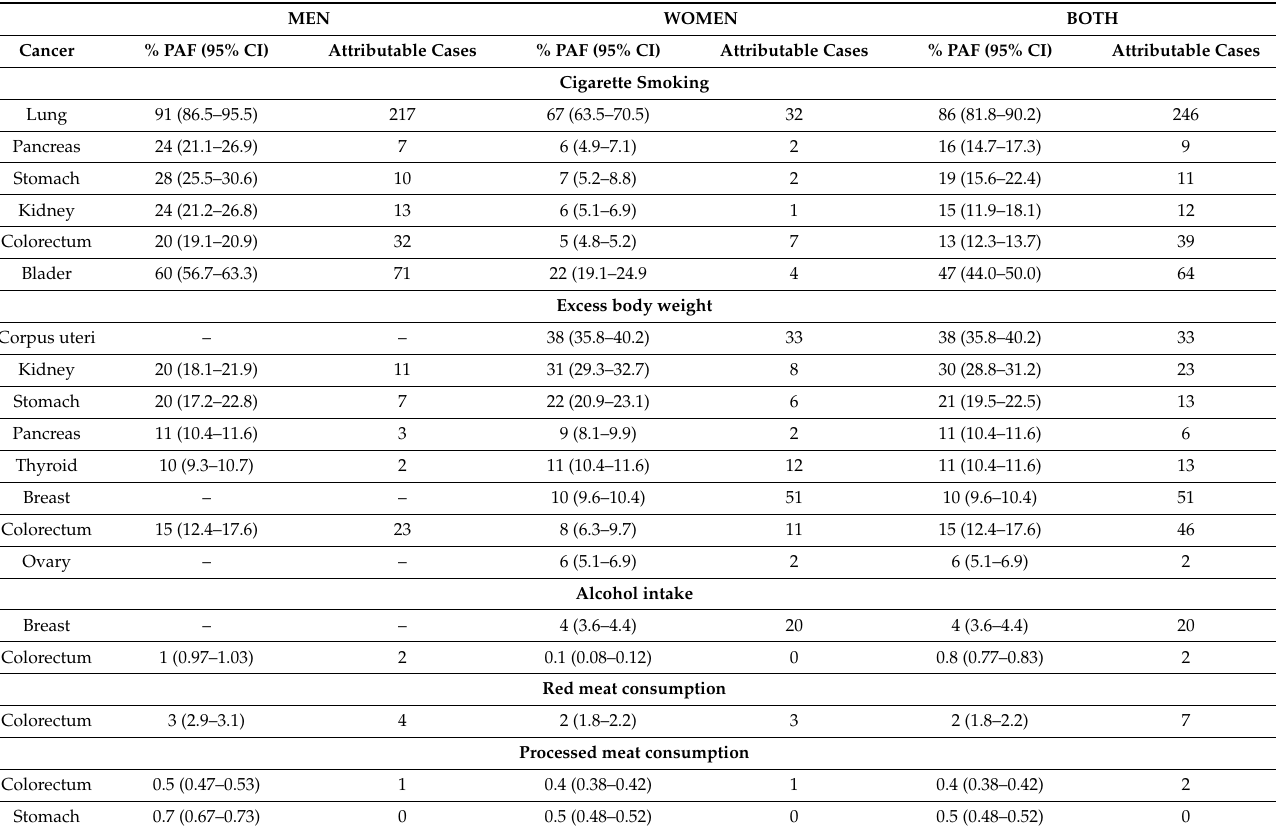
Table 4. Estimates cancer cases in Arab adults aged 30 years and older in Israel in 2015 attributable to potentially modifiable risk factors by sex, risk factor, and cancer